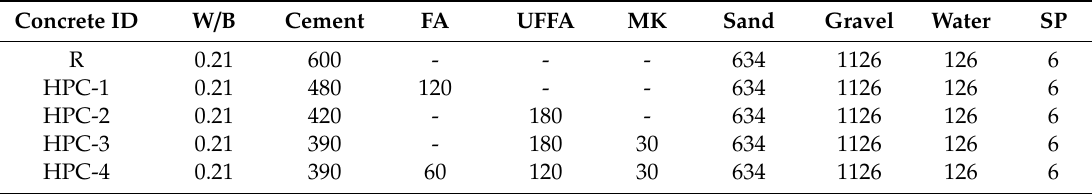
Table 3. Mix proportions of concrete (kg / m 3 ).